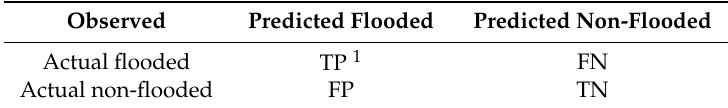
Table 2. Confusion matrix description.